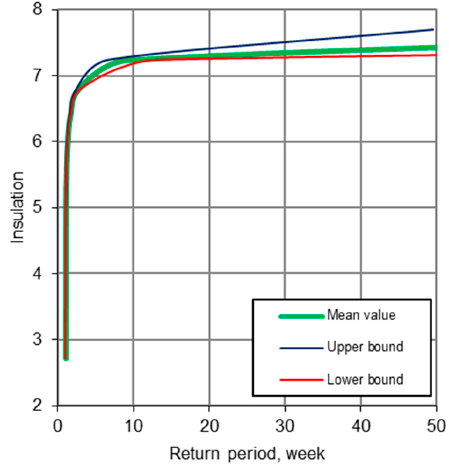
Figure 11. Return period of queuing time ( left ) and wind speed ( right ).